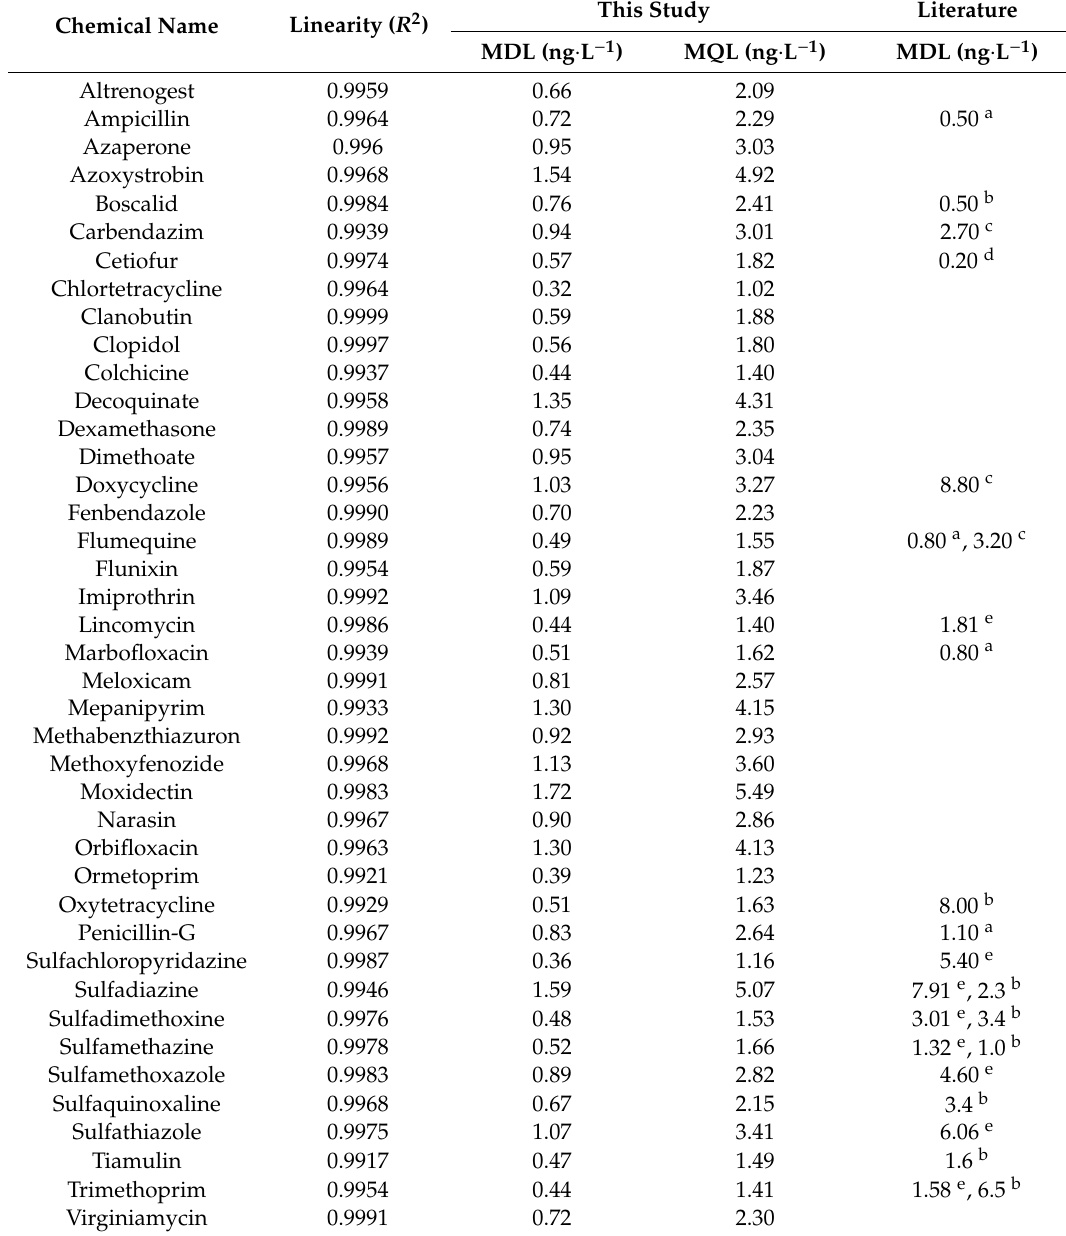
Table 4. Method validation data of the developed method with on-line SPE for target chemicals. MDL—method detection limit; MQL—method quantitation